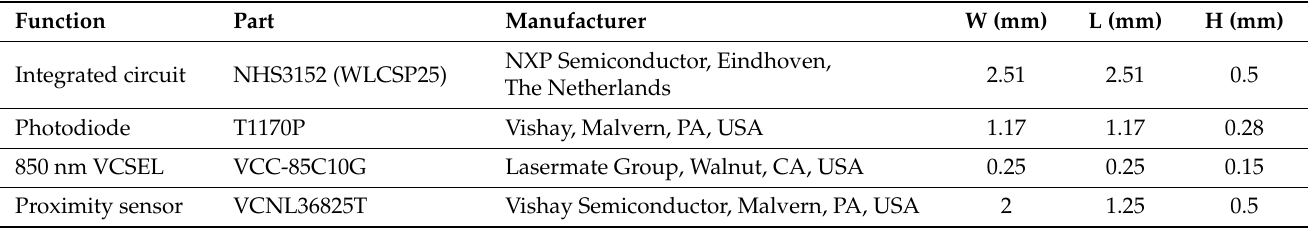
Figure 9. SCL simplified block diagram with the three functions for on-lens computation, built around the NHS3152 smart sensor IC from NXP. Table 1. Multimodal SCL parts’